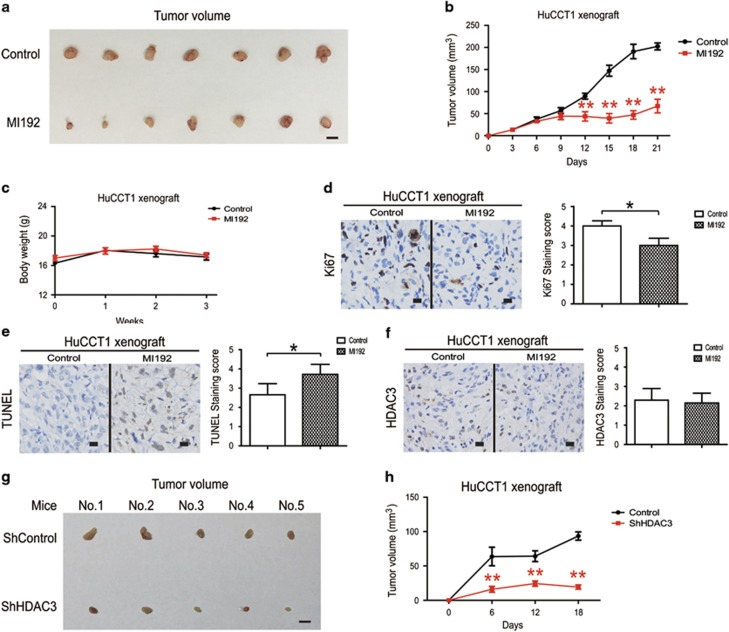
Effects of MI192 on tumor xenografts. (a) Systemic delivery of MI192 suppresses CCA cell xenograft tumor growth in nude mice. Tumors were photographed after all animals were killed. Scale bars, 1 cm. (b) The xenograft tumor sizes. (c) The body weights of tumor-burdened mice. (d) Xenograft samples were stained with Ki-67 (left) and staining was quantified (right). The magnification is x200. Scale bars, 100 μm. (e) Xenograft samples were stained with TUNEL (left) and staining was quantified (right). The magnification is x200. Scale bars, 100 μm. (f) Xenograft samples were stained with HDAC3 (left) and staining was quantified (right). The magnification is x200. Scale bars, 100 μm. (g) HDAC3 knockdown HuCCT1 cells and control counterparts were injected at the left and right sides of the same mice. Tumors were photographed after all animals were killed. Scale bars, 1 cm. (h) Xenograft tumor sizes. Data represent the mean±S.E.M., n≥3. *P<0.05 and **P<0.01; NS not significant